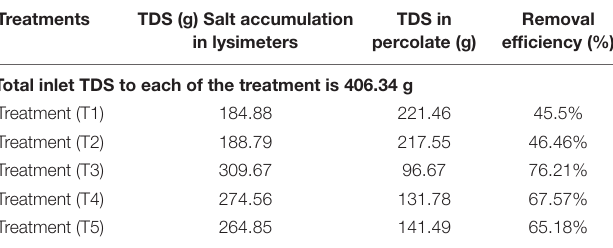
TABLE 7 | Overall salt accumulation in terms of TDS (g) in different treatments throughout the study. Treatments TDS (g) Salt accumulation TDS in in lysimeters percolate